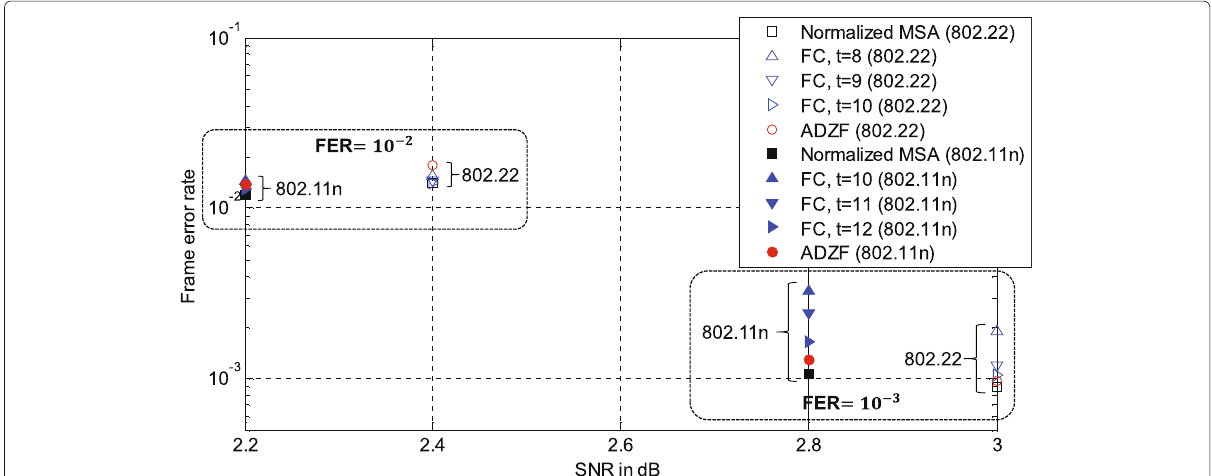
Fig. 16 Frame error rate of each scheme when 802.22 LDPC codes and 802.11n LDPC codes are used. The simulated error region is that the frame error rate of normalized min-sum is approximately 10 − 2 and 10 −